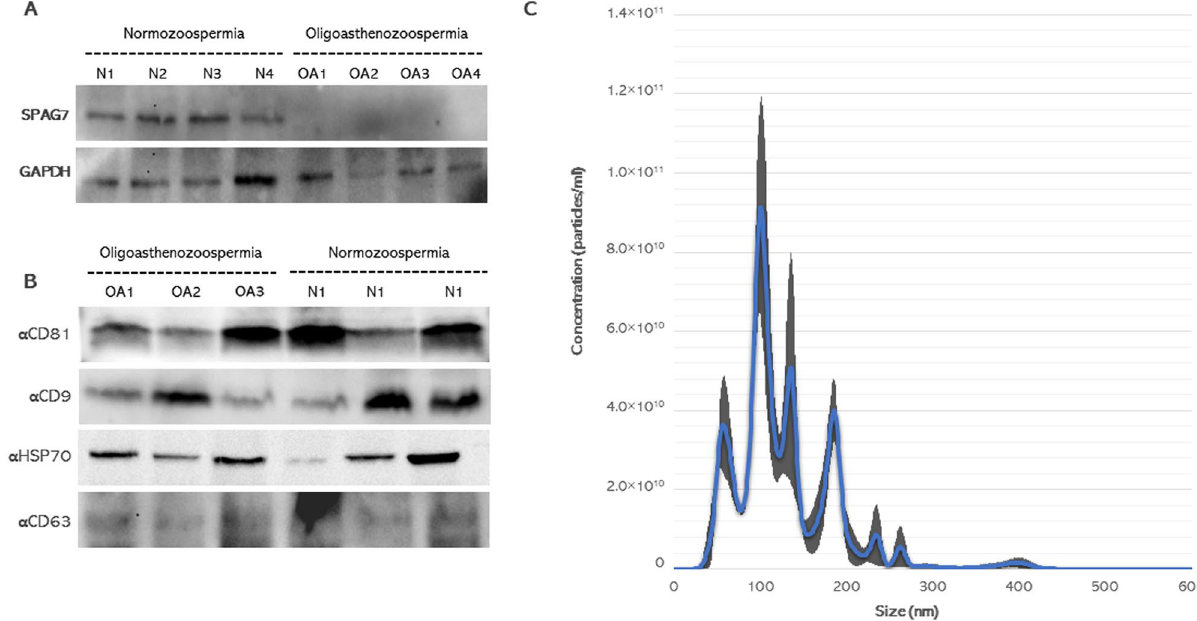
Figure 2. Western blot analysis of ( A ) SPAG7 (~ 26 kDa) and GAPDH (~ 37 kDa) protein levels in the sperm from oligoasthenozoospermic (OA, n = 4) and age-matched normozoospermic men (N, n = 4), ( B ) EVs marker proteins CD81 (~ 26 kDa), CD9 (~ 28 kDa), HSP70 (~ 70 kDa), and CD63 (~ 53 kDa) from sex independent SP-EVs samples, and ( C ) Nanoparticle tracking analysis of particle size and concentration from three independent SP-EVs samples. Mean ± SEM of particle concentration was indicated. Gray is the standard error and the blue line indicates the mean of technical